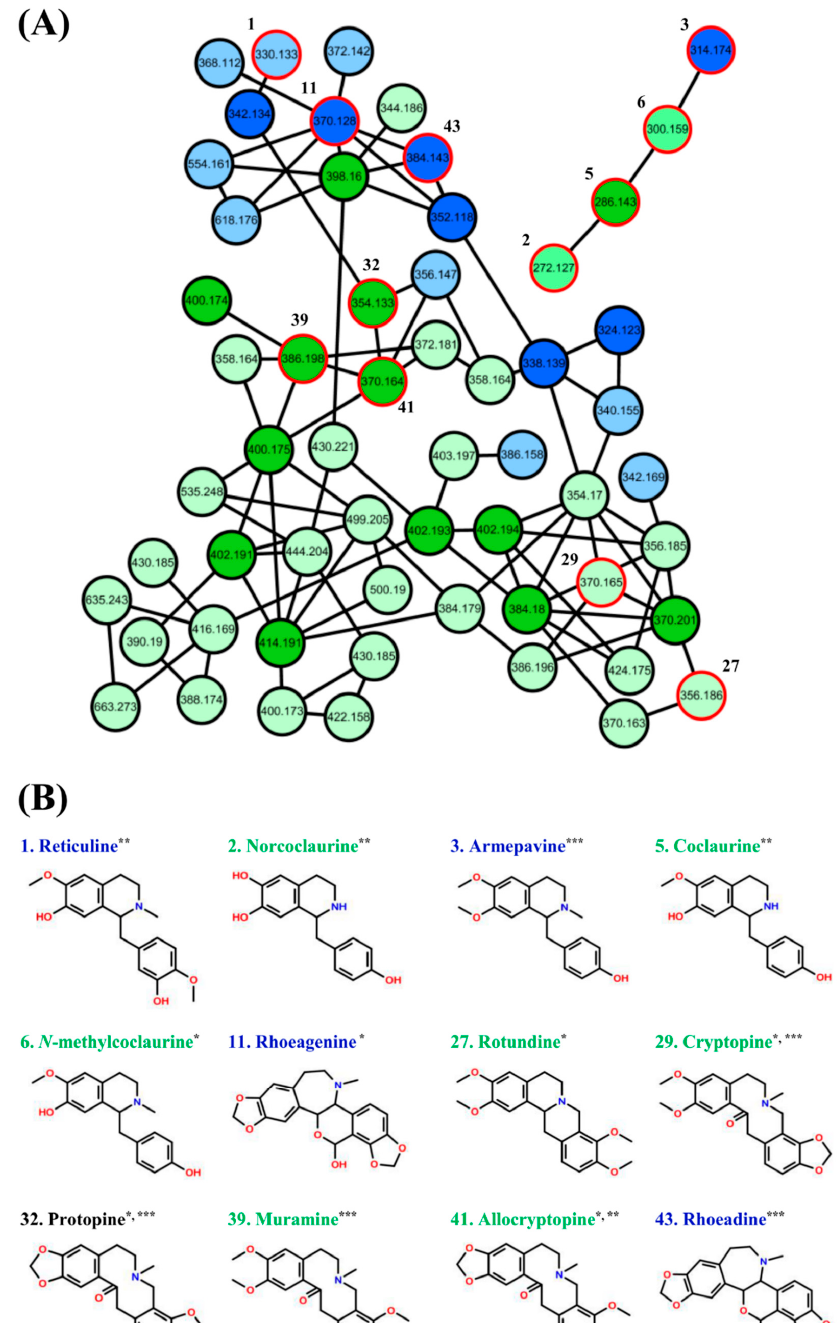
Figure 1. ( A ) Alkaloid-targeted molecular network generated from the ethanolic extracts of P. nudicaule and P. rhoeas . Colors inside nodes represent species-specific metabolites: green, P. nudicaule ; blue, P. rhoeas . ( B ) Nodes with red outer circles represent ions dereplicated by GNP libraries (*), authentic compounds (**), and literature (***). Identified ions are presented with their common names and chemical